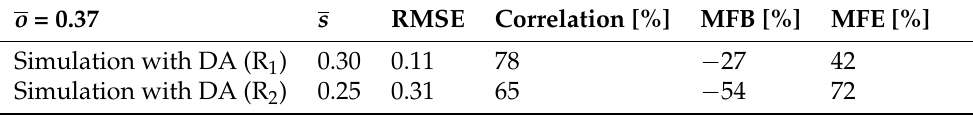
Table 7. Statistics of hourly simulated AOD with DA using two influence radii R 1 and R 2 to AERONET measurements comparisons for daily AOD during March 2009. s and RMSE are ex- pressed in µ g · m − 3